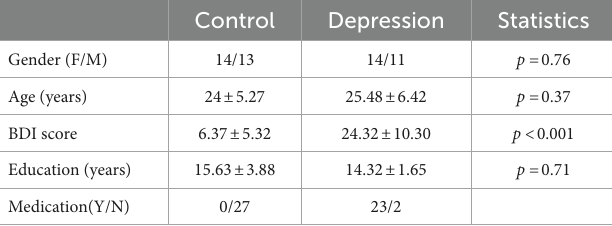
TABLE 1 Demographic and clinical characteristics of participants (mean ±